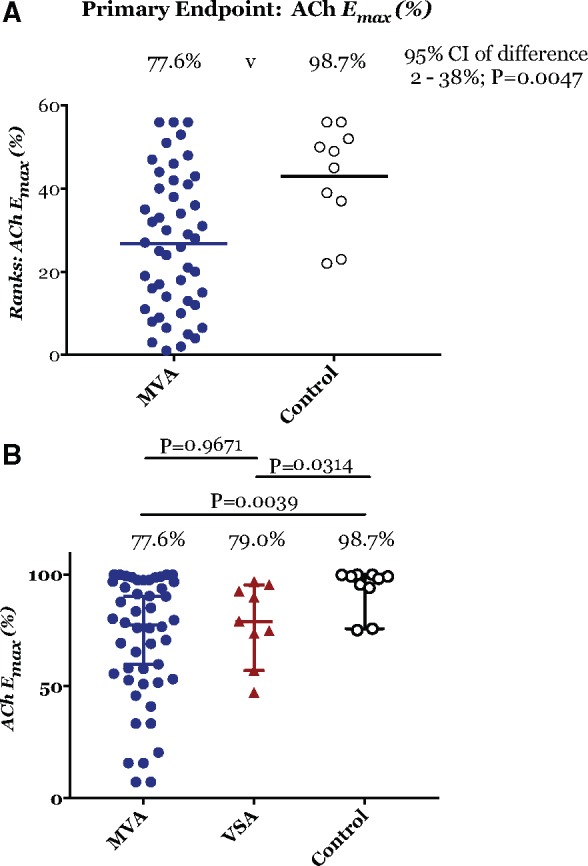
(A) Primary endpoint: maximum vasorelaxation to acetylcholine (Emax). (B) Comparison of maximum relaxation to acetylcholine between the three groups. (A) Ranks: the Mann–Whitney U test ranking of microvascular angina vs. control subjects confirming significantly lower maximum vasorelaxation in response to acetylcholine between microvascular angina patients and control subject (median 77.6 vs. 98.7%; 95% confidence interval of difference between medians 2.3–38%; P = 0.0047). (B) Comparison of three groups confirming both microvascular angina subjects (blue circle; acetylcholine Emax 77.6%, n = 48) and vasospastic angina subjects (red triangle; acetylcholine Emax 79%, n = 9) had reduced maximum vasorelaxation to acetylcholine than vs. control subjects (○—white circle, Emax 98.7%, n = 10). Significance P < 0.01 and P = 0.03, respectively using the Kruskal–Wallis test (adjusted for multiple comparisons by controlling the false discovery rate). Each measure represents mean ± 95% confidence intervals for mean in shaded contours from CCRC best-fit. There were no significant differences in maximum relaxation to acetylcholine between microvascular angina and vasospastic angina subjects (P = 0.96).